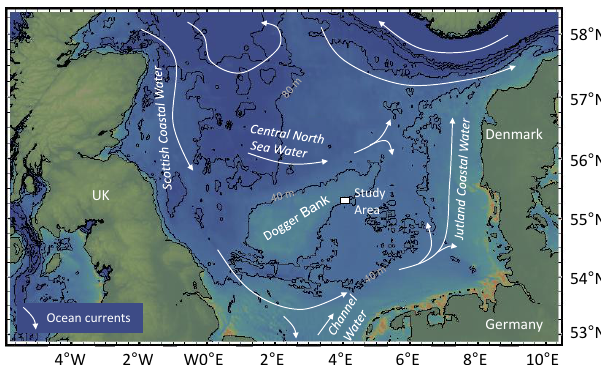
Figure 1. Location of the study area in the central North Sea. The main currents are shown following Howarth (2001). The map was drawn using GeoMapApp with 40m